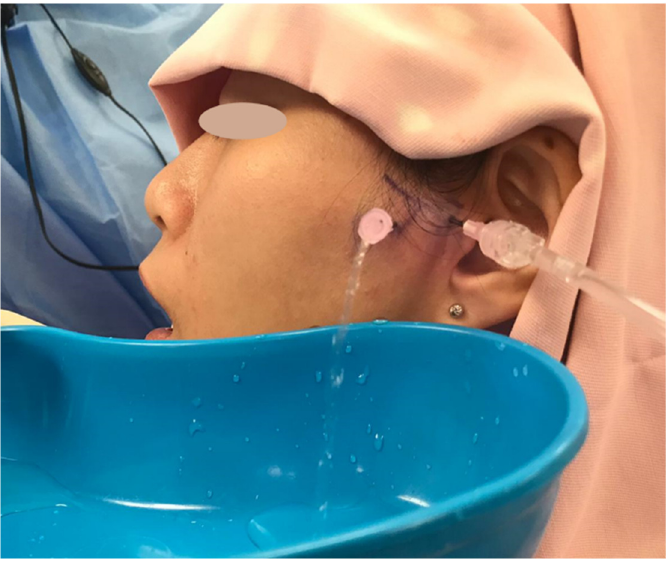
Figure 3. Arthrocentesis performed under local anaesthesia.